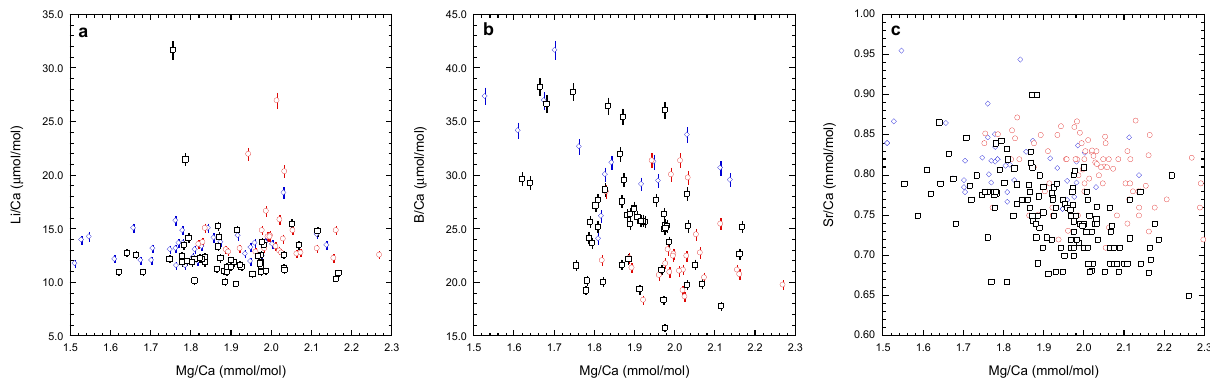
Fig. 2. Cross-plots of contemporaneous O. umbonatus Li/Ca, B/Ca and Sr/Ca data against Mg/Ca. The different colour and symbol combi- nations denote different intervals of the record. The intervals represent < 10 6 yr (b) and (c) and 5.7 × 10 5 yr (a) , which do not exceed the residence time of the X or Ca ions in the ocean. Error bars for Li/Ca and B/Ca measurements denote analytical precision, estimated to be ∼ 2% based on replicate foraminiferal analyses. The uncertainty associated with Sr/Ca precision is smaller than the size of the data symbol.